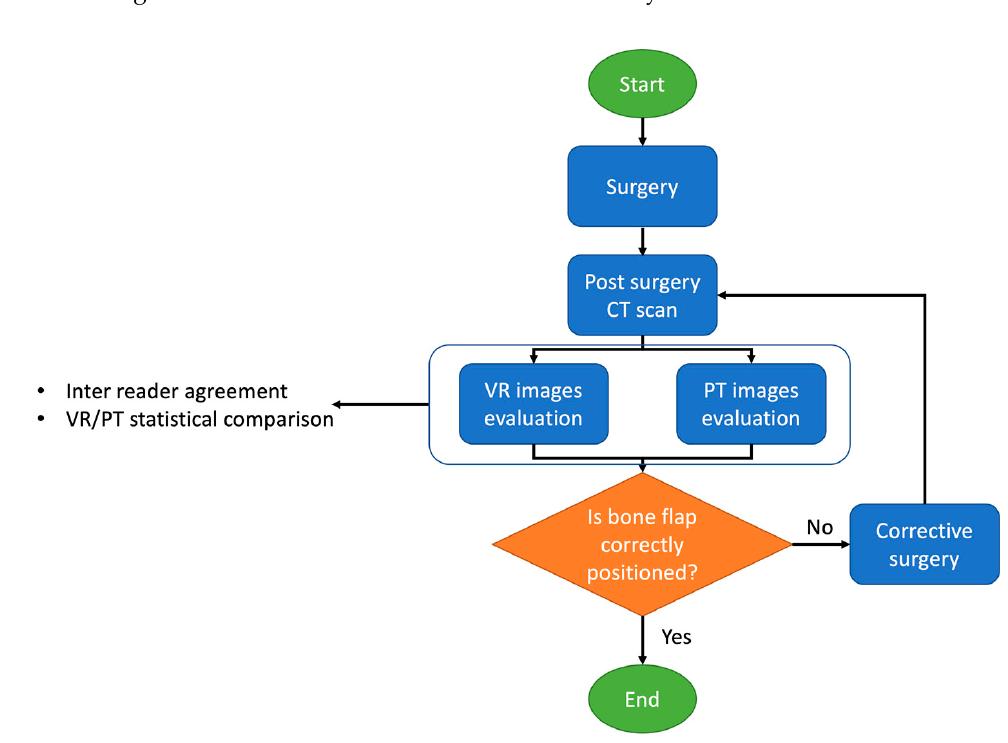
Figure 1. Flowchart of the study.